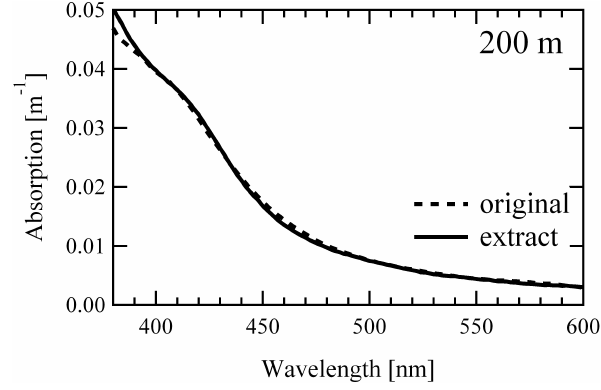
Fig. 7. CDOM absorption spectra of a methanolic DOM extract from 200m and the absorption of the corresponding original sample. The absorption of the extract was adjusted to fit to the absorption of the original sample. Deviations at < 380nm are due to larger measurement errors of the regular sample absorption at these wavelengths in the PSICAM